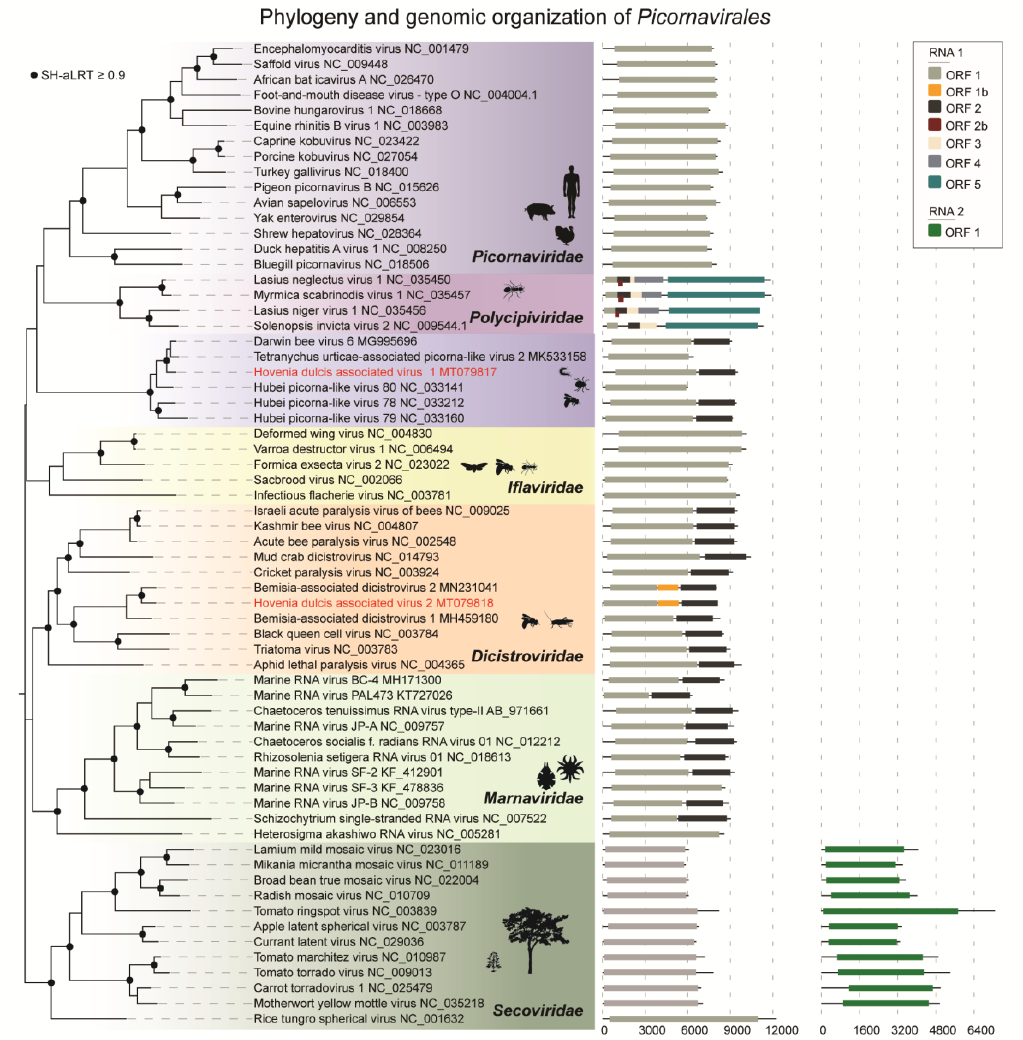
Figure 2. Phylogeny and genomic organization of representative members of the order Picornavirales . Phylogenetic analysis based on the amino acid sequence of RdRp (RNA-dependent RNA polymerase) of members from six families within the order Picornavirales . Sequences were aligned with ClustalW [30] and the maximum likelihood tree inferred with FastTree [31]. The black circles represent nodes with aLRT ≥ 0.9. Hovenia dulcis -associated virus 1 (HDaV1) and Hovenia dulcis -associated virus 2 (HDaV2) are highlighted in red. The genome organization was plotted with the Evolview v3 program